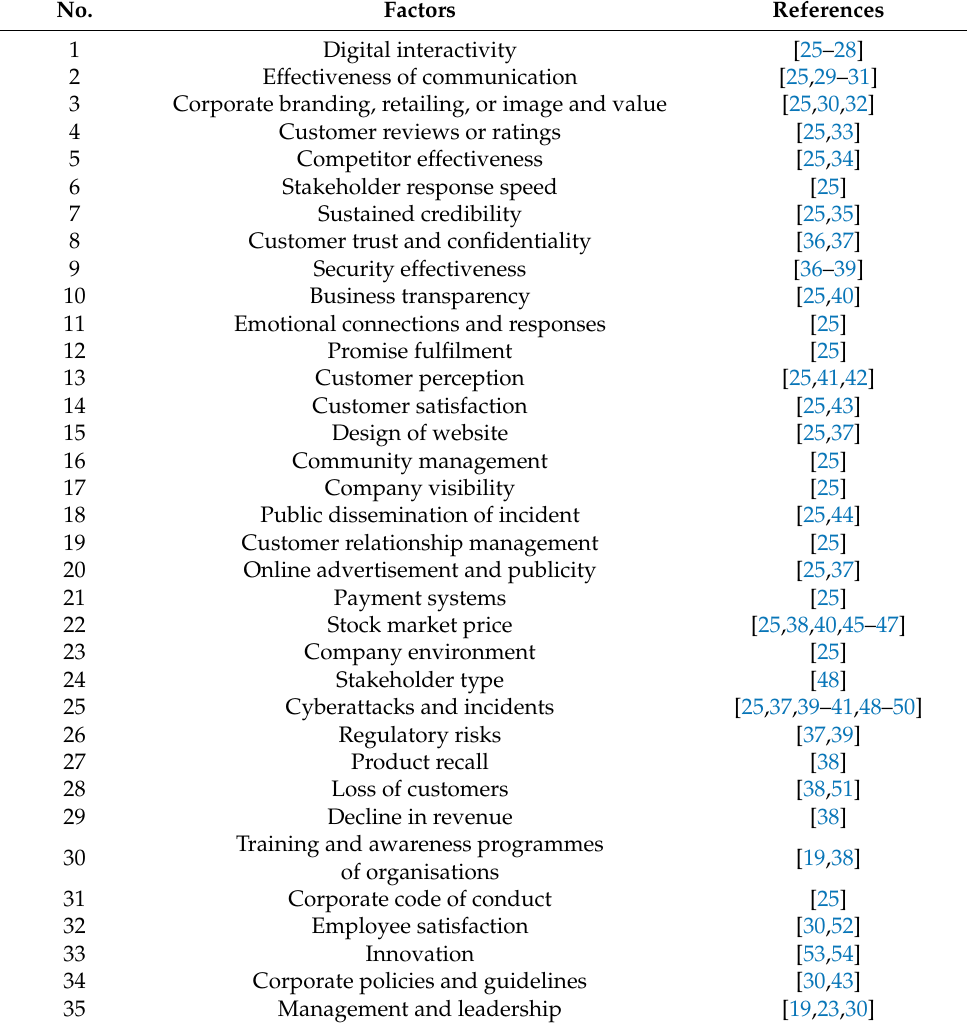
Table 1. Factors affecting the reputation of organisations.